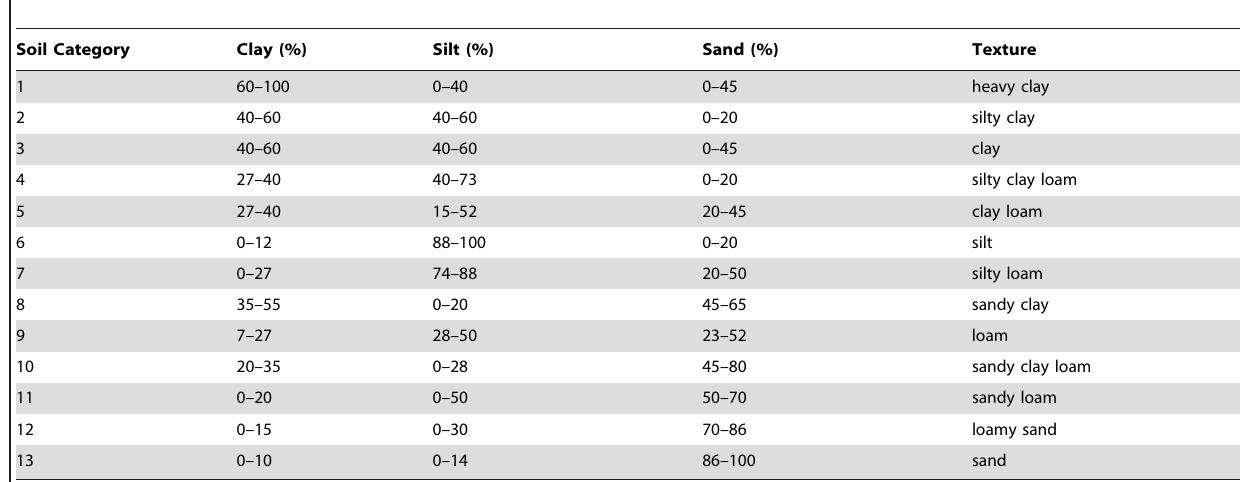
Table 2. Soil texture categories, along with the respective percentages of Clay, Silt and Sand, according to USDA soil textural classification